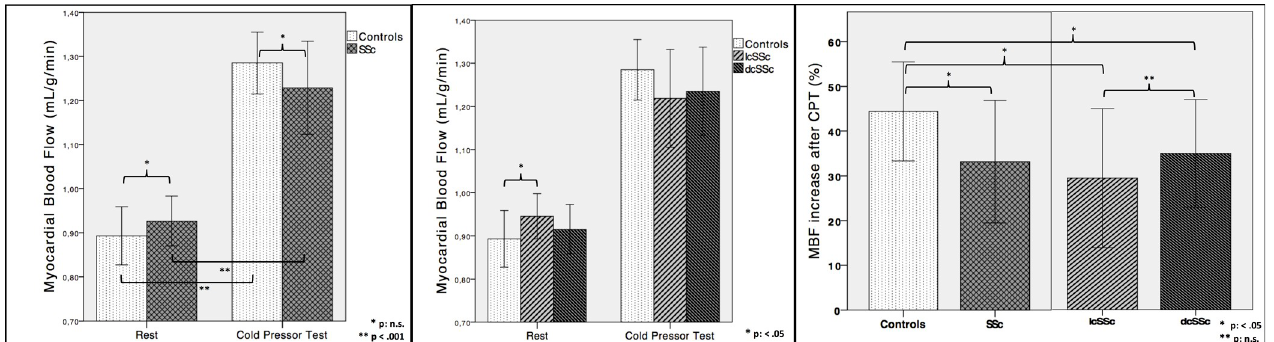
Fig 4. Box plot graphs of myocardial blood flow (MBF) at rest and after cold pressor test (CPT). Mean values, +/- 1 Standard Deviation bars; SSc = systemic sclerosis; lcSSc = limited cutaneous form; dcSSc = diffuse cutaneous form.